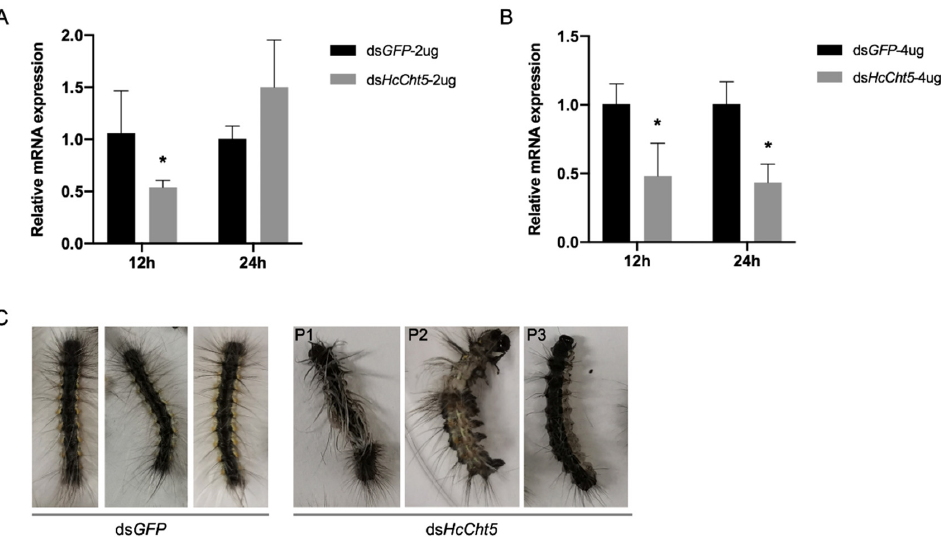
Figure 3. RNAi efficiency of HcCht5. ( A ) The relative mRNA expression levels of HcCht5 after injection with 2 ug ds HcCht5 and ds GFP . ( B ) The relative mRNA expression levels of HcCht5 after injection with 4 ug ds HcCht5 and ds GFP . dsRNAs were injected in L3D5 instar (the day before molting) larvae. The relative mRNA expression levels of HcCht5 were deter- mined using RT-qPCR at 12 h and 24 h post injections. Error bars represent the standard error of the calculated means based on three biological replicates. Asterisks indicate significant differences (Student’s t -test, p < 0.05). ( C ) The abnormal molting phenotypes of H. cunea larvae after injection with ds HcCht5 . Insects injected with ds GFP were able to molt suc- cessfully, while the ds HcCht5- injected insects displayed three abnormal molting phenotypes: P1, some larvae could shed the epidermis but did not molt completely; P2, some larvae stopped molting halfway; and P3, some larvae completely failed to molt. Table 1. The abnormal rate and mortality rate of H. cunea after injection of ds HcCht5 in different concentrations.